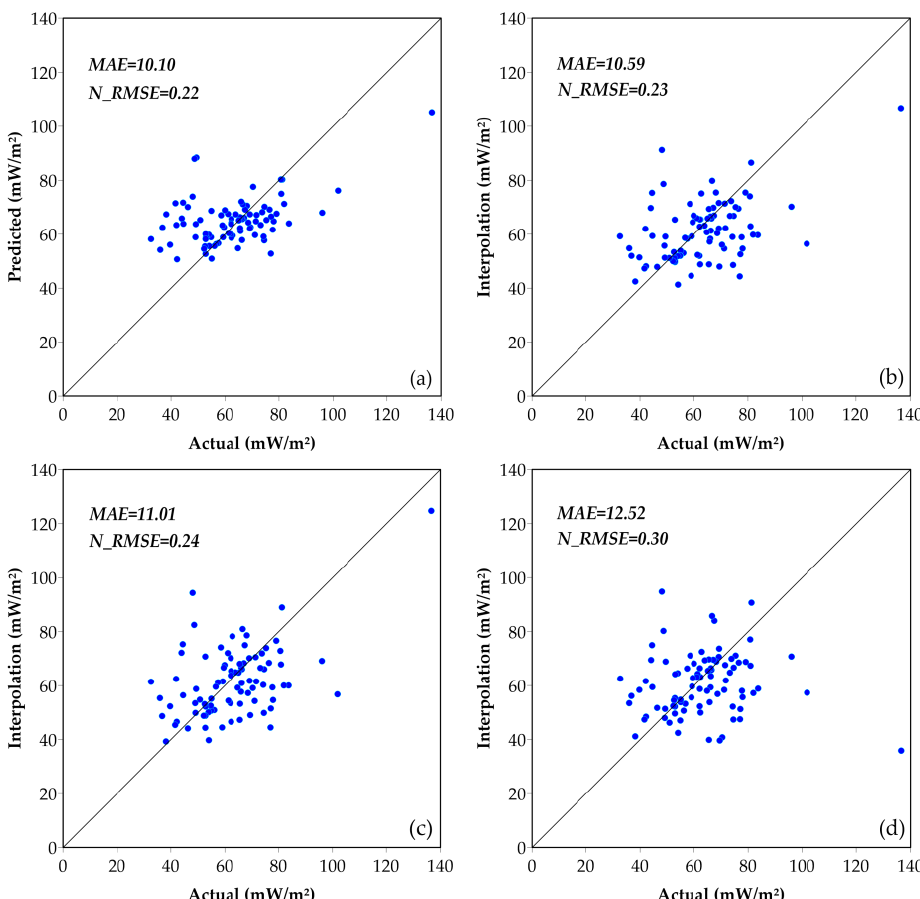
Figure 5. The prediction performance of GBRT ( a ), kriging interpolation ( b ), minimum curvature interpolation ( c ), and 3D interpolation ( d ).